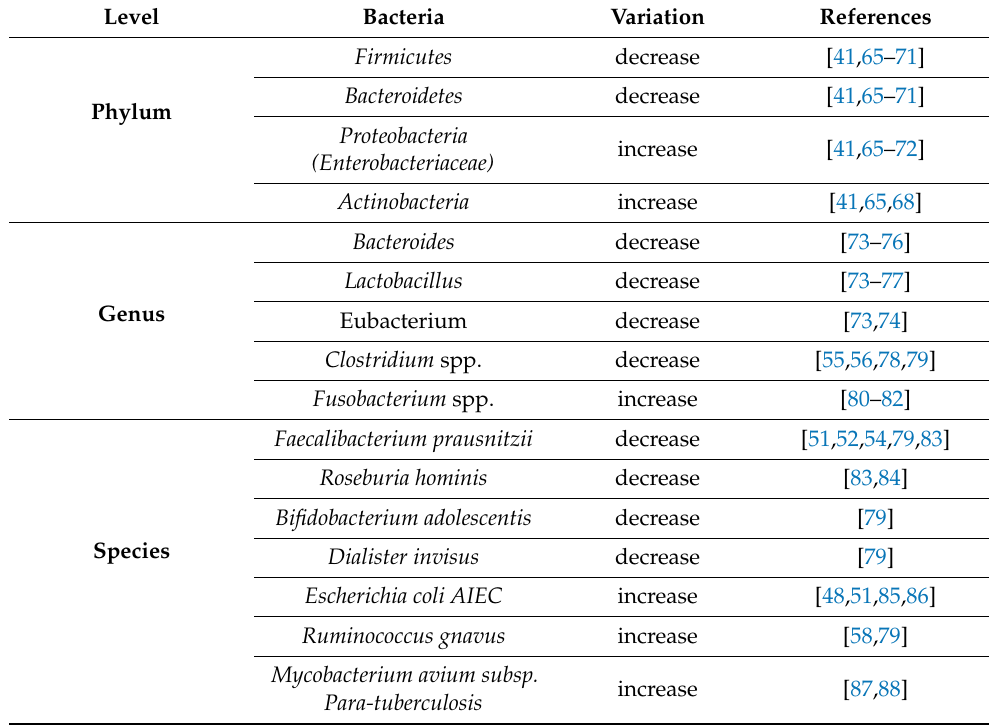
Table 1. Main bacterial changes in the Phylum, Genus, and Species levels of the human microbiome associated with inflammatory bowel diseases